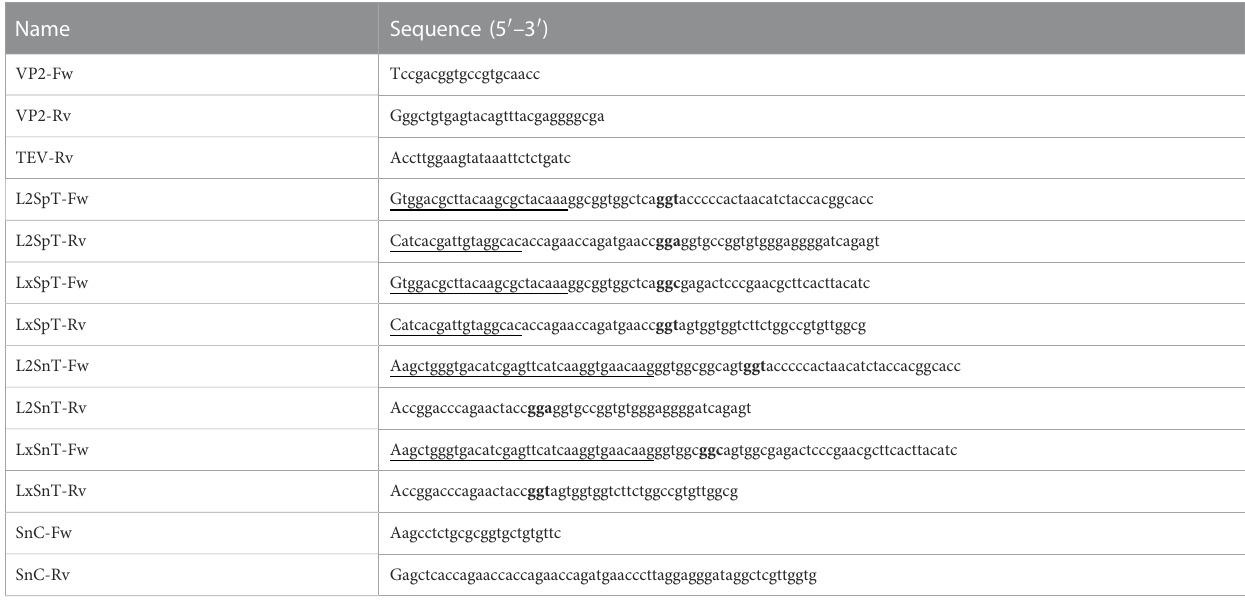
TABLE 1 List of primers used in this study. Name Sequence (5 ′ – 3 ′